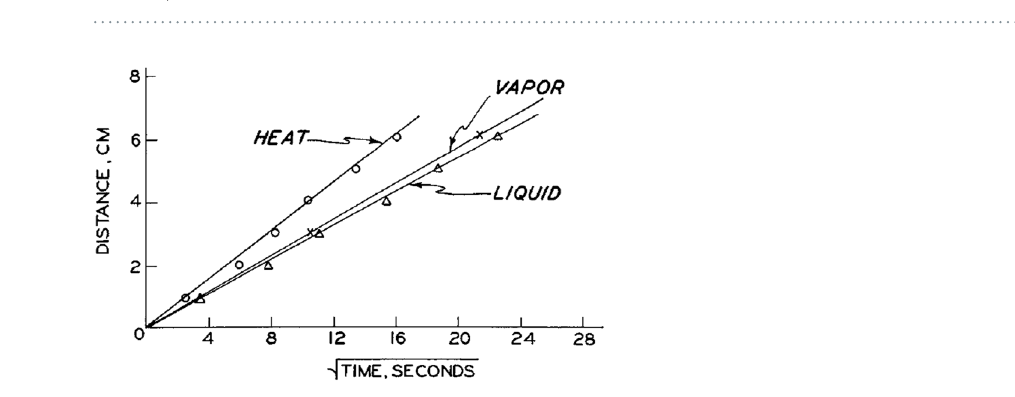
Figure 8. Instantaneous increase of relative humidity at various positions along the column (from Perrier and Prakash) 9 .